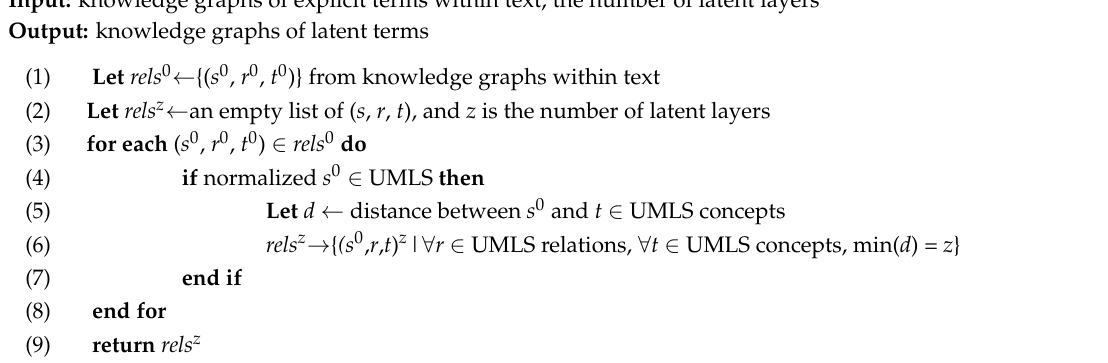
Algorithm 3 Latent knowledge discovery